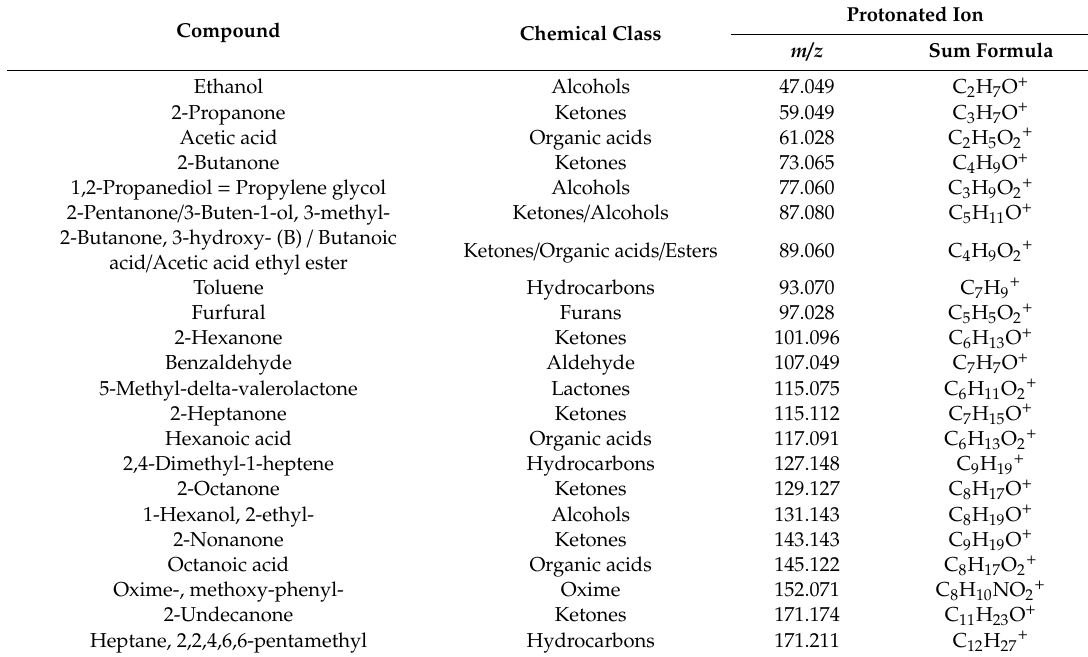
Table 2. Volatile compounds detected by both Proton Transfer Reaction-Mass Spectrometry coupled to a Time of Flight mass analyzer (PTR-ToF-MS) and SPME / GC-MS in association with mascarpone